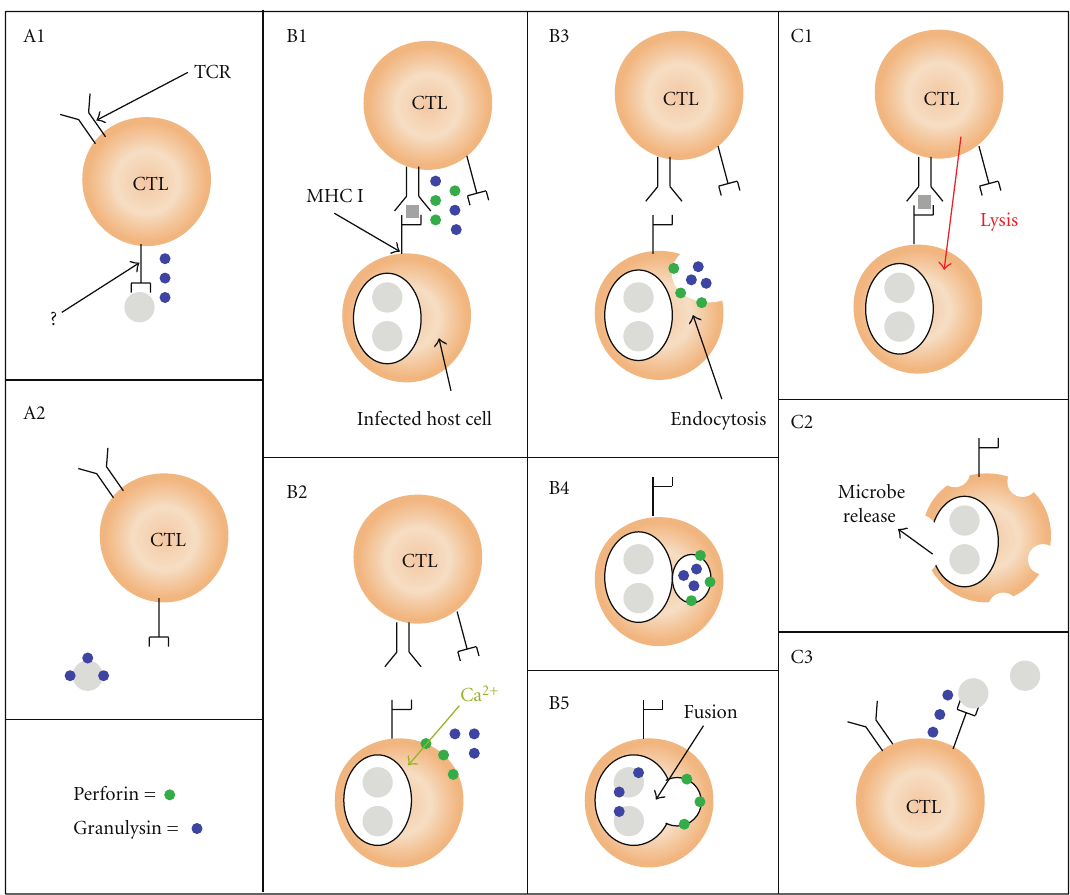
Figure 1: Killing of extracellular and intracellular microbes by CTL. (A) CTL bind to an extracellular microbe (grey) via an unknown receptor (?) independently of MHC (panel A1). Binding triggers CTL to release granulysin (blue) which binds to and kills the microbe (panel A2). By contrast, CTL killing of intracellular microbes involves MHC-restricted antigen-specific recognition of infected host cells. (B) CTL-host cell interactions induce the release of perforin (green) and granulysin (panel B1). Perforin-generated pores in the host cell membrane facilitate the influx of extracellular Ca 2+ which induces endocytosis of the membrane region damaged by perforin, along with nearby granulysin (panels B2–B4). Granulysin-containing endosomes fuse with intracellular compartments containing the microbe allowing granulysin to bind to and kill the microbe (panel B5). (C) Alternatively, CTL induce lysis of an infected host cell causing the release of intracellular microbes which are then killed by other nearby CTL (panels